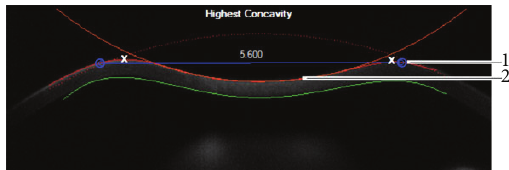
Figure 2: Display of the deflection length and the highest concavity. (1) Deflection length; (2) highest